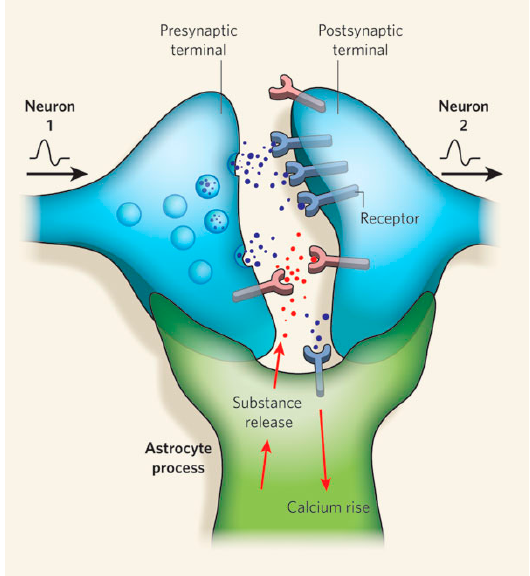
Figure 13. Tripartite synapse represented by a presynaptic neuron, postsynaptic neuron and perisynaptic astrocyte (astrocyte process). The presynaptic neuron release neurotransmitters that are received by the postsynaptic neuron or the perisynaptic astrocyte [129].